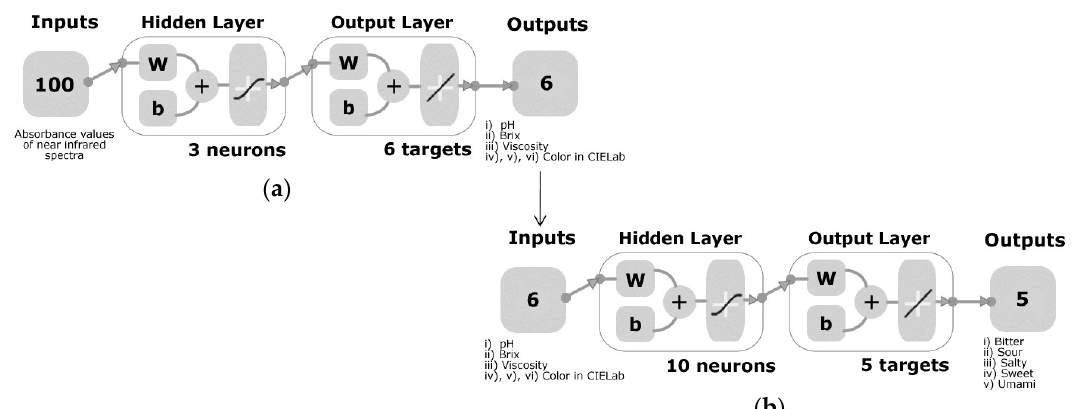
Figure 1. Diagrams with a two-layer feedforward network and tan-sigmoid function in the hidden layer, and a linear transfer function in the output layer for (a) Model 1 constructed with 100 inputs from near-infrared readings, three neurons and six targets related to physicochemical data of chocolate, and (b) Model 2 developed using six inputs obtained from the output of Model 1, ten hidden neurons and five targets related to basic taste intensities of chocolate. For the hidden and output layers, w = weights and b = biases.